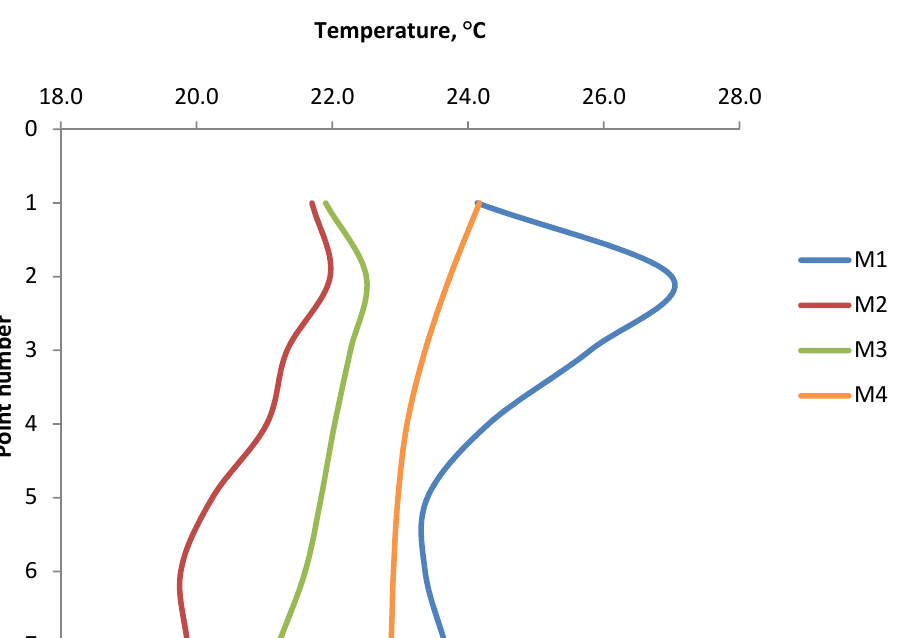
Figure 12. The temperature distribution on the back side briquette surfaces .